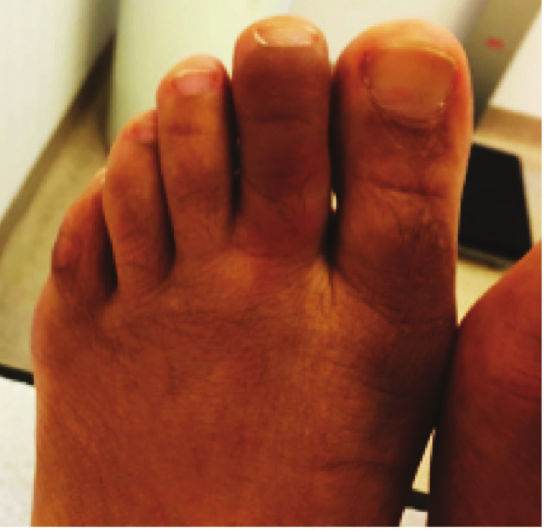
Figure 1: Diffuse swelling of the second right toe (“sausage” like) consistent with